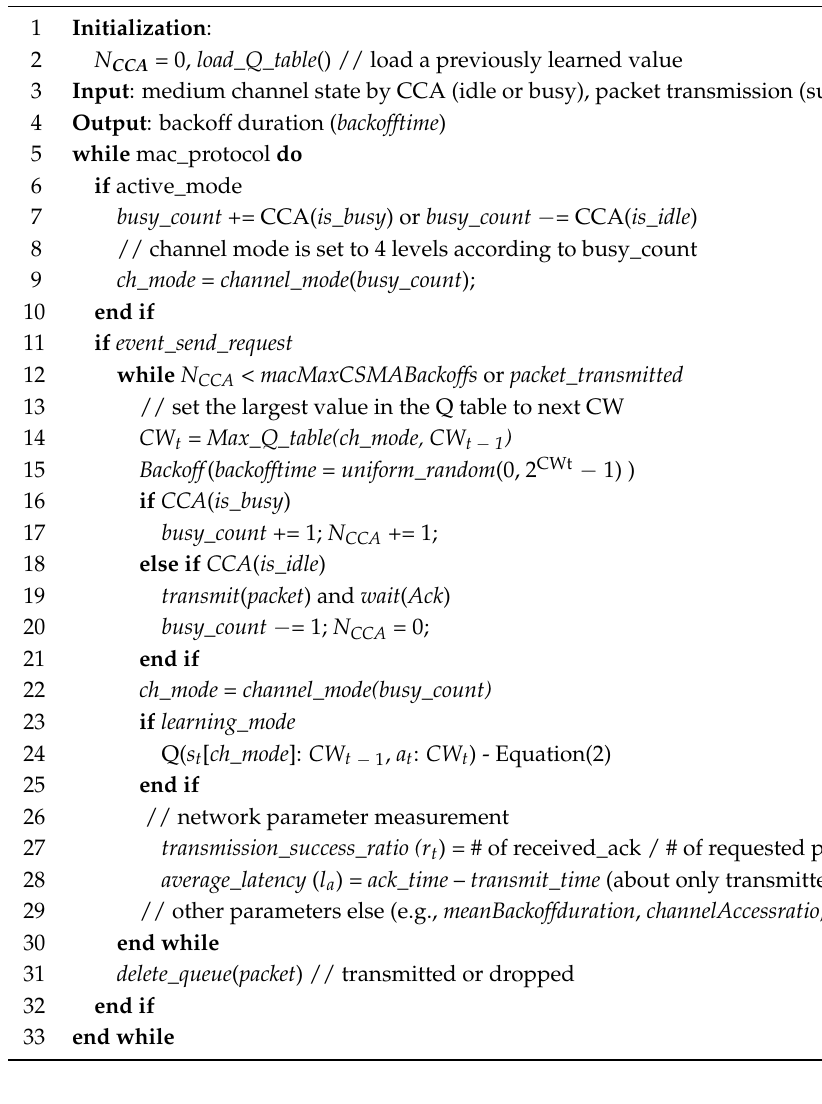
Algorithm 1: Q-learning-based Backoff